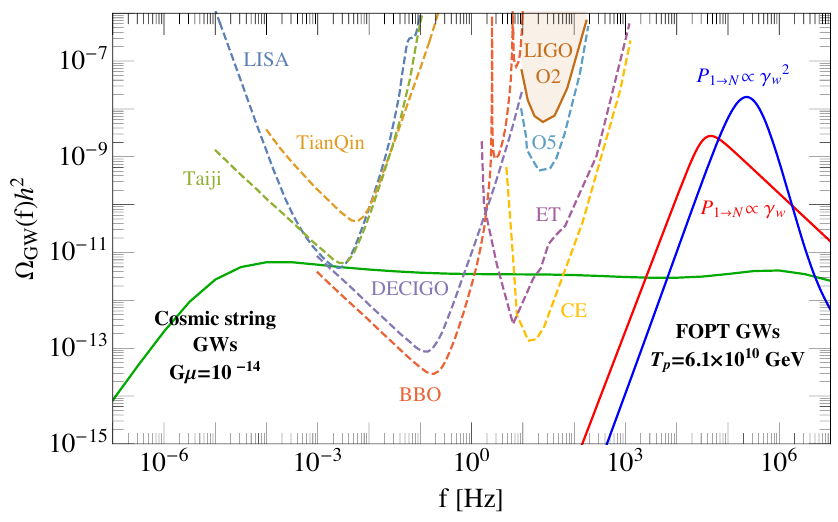
Figure 3 . The GW spectra for the benchmark λ φs = 3 . 5 and g B − L = 0 . 05 (marked as green star in figure 2). Both the spectra from cosmic strings and FOPT are shown, and in the latter case both two possibilities of P 1 → N ∝ γ 2 (sound wave dominant) and P 1 → N ∝ γ w (bubble collision w dominant) are